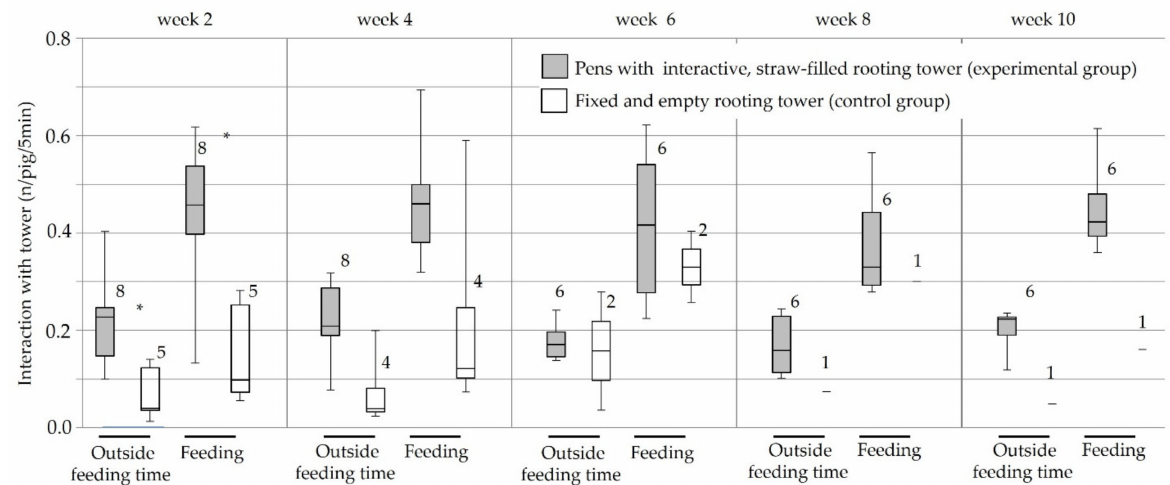
Figure 8. Average frequencies of tower manipulations per pig within five minutes in the experimental (interactive tower) and control (stationary tower) group. Boxes represent the 50% between 25% and 75% quartiles. The line inside the box indicates the median. The top and bottom lines denote maximum and minimum values. Observation time (Outside feeding time = before and after feeding and during feeding) and week of fattening is indicated. Numbers of evaluated pens are depicted next to the bars. Several pens were removed from data analysis due to severe tail biting outbreaks which required interventions such as providing additional straw and separating the pen * p < 0.05, Mann–Whitney U test; experimental versus control